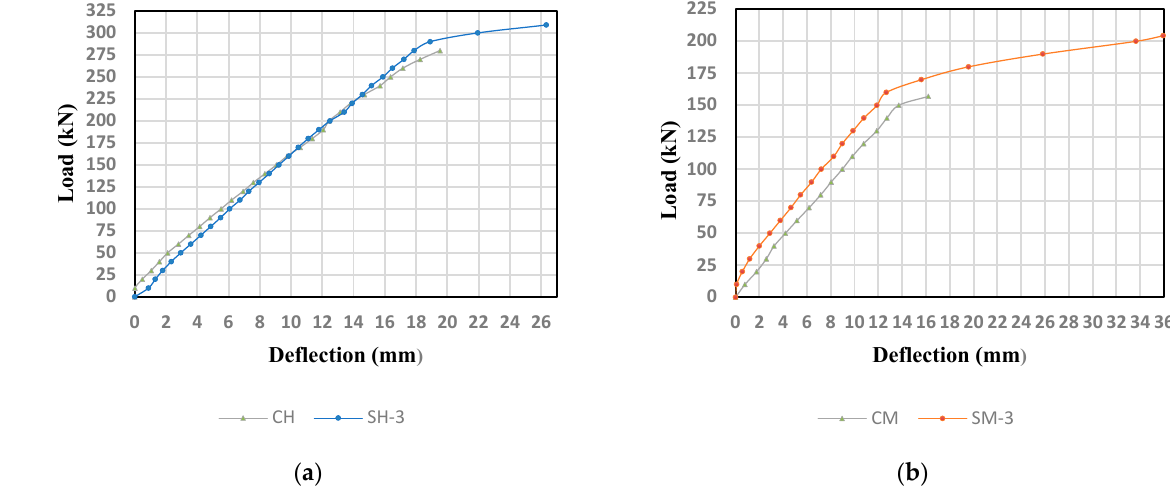
Figure 12. Load–deflection curve for: ( a ) CH and SH-3, ( b ) CM and SM-3.